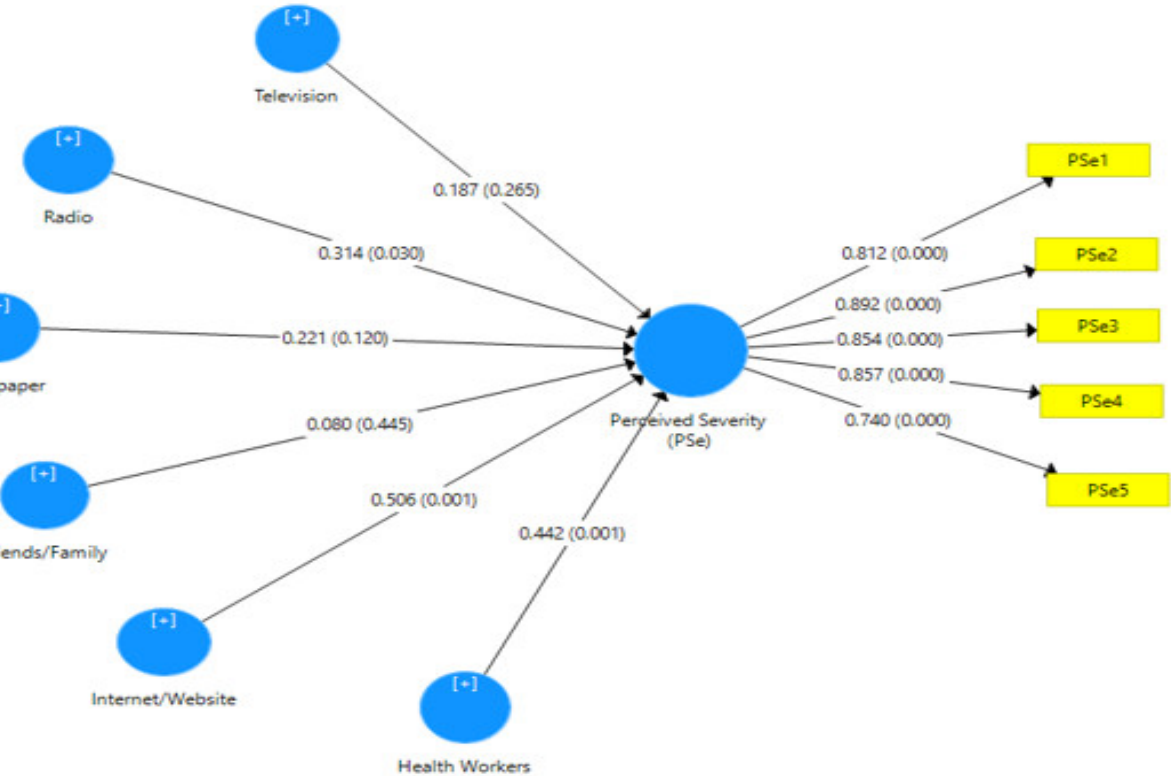
Figure 2. Information sources and women’s perceived severity of breast cancer model. Table 6. Construct validity and reliability for Hypothesis